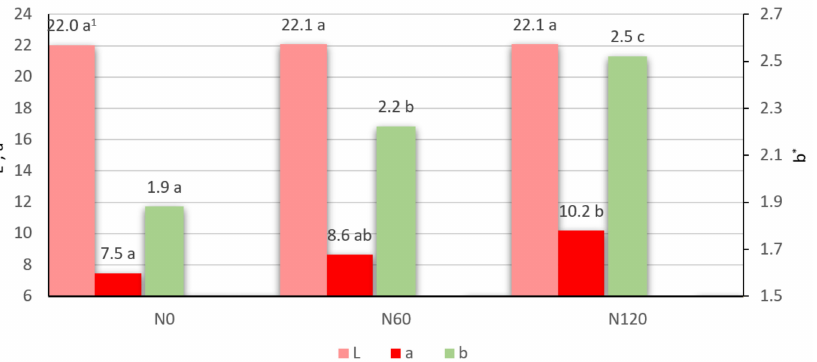
Figure 14. The effect of nitrogen fertilization on the colour. Average for all orchards (OR 1, OR 2, OR 2) in years 2007–2013. L* indicates darkening of fruit at the time of harvest; a* indicates chromaticity on a green ( − ) to red (+) axis; b* chromaticity on a blue ( − ) to yellow (+) axis. 1 means that the same letters are not significantly different at α = 0.05 (Duncan’s